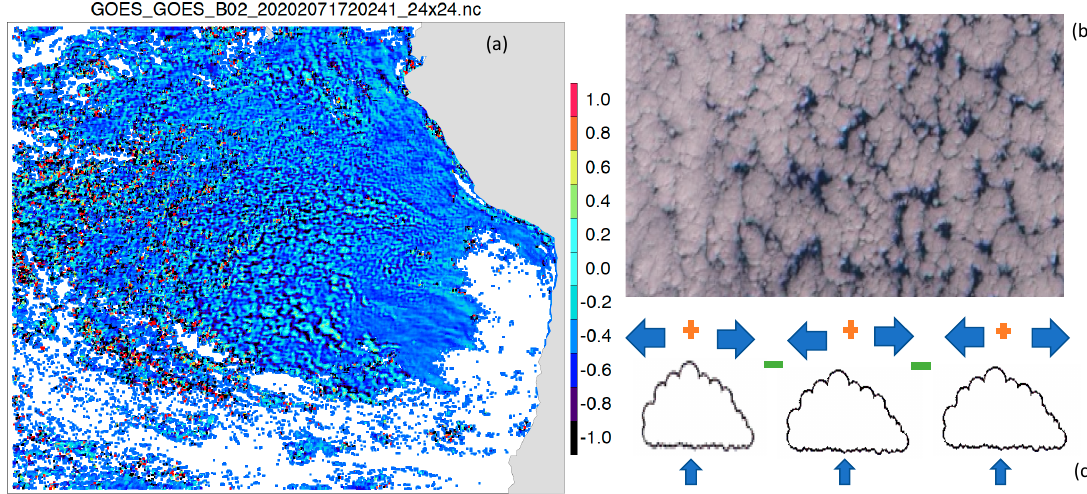
Figure 19. ( a ) The mesoscale divergence derived from stereo-wind AMV retrievals using a template size of 24 pixels × 24 pixels. Only divergence values at CTH < 3 km are shown. The divergence is calculated from the AMVs in a 36 km × 36 km domain but sampled at the 12 km × 12 km grid. An image of closed and open cells of stratocumulus clouds is shown in ( b ). The divergence and convergence associated with cloud cells are illustrated in ( c